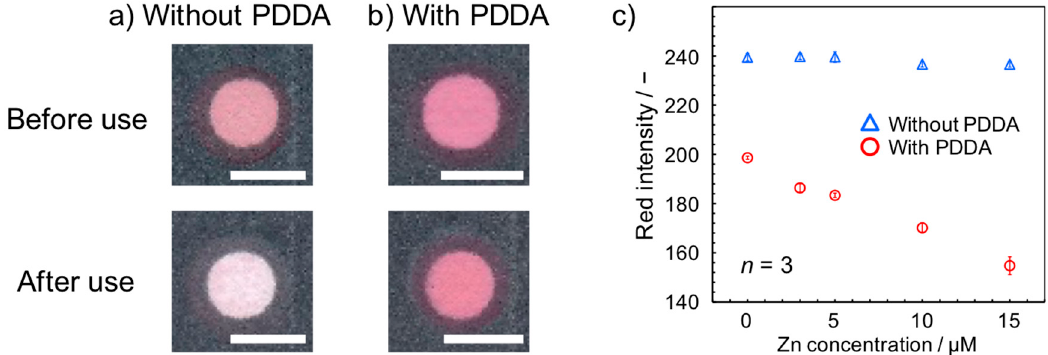
Figure 2. Immobilization of Zincon by poly(diallyldimethylammonium chloride) (PDDA). Scanned images of the detection areas before and after introduction of 1 mL water ( a ) in the absence and ( b ) presence of 10 cycles of inkjet deposited PDDA (scale bars: 4 mm); ( c ) quantitative evaluation of the colorimetric response to Zn 2+ in the presence (red markers) and absence (blue markers) of PDDA (in this experiment, the glass fiber layers contain salicylaldoxime, buffer component, and CuCl 2 ).